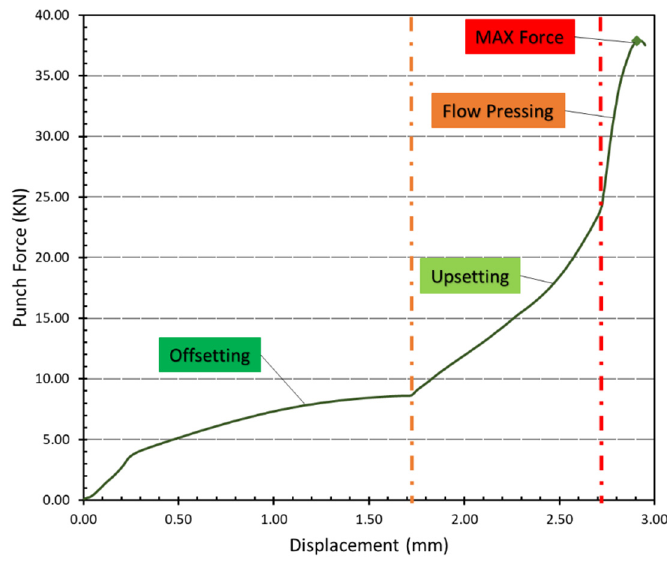
Figure 15. Force–displacement diagram of clinch joint SPCC mild steel.